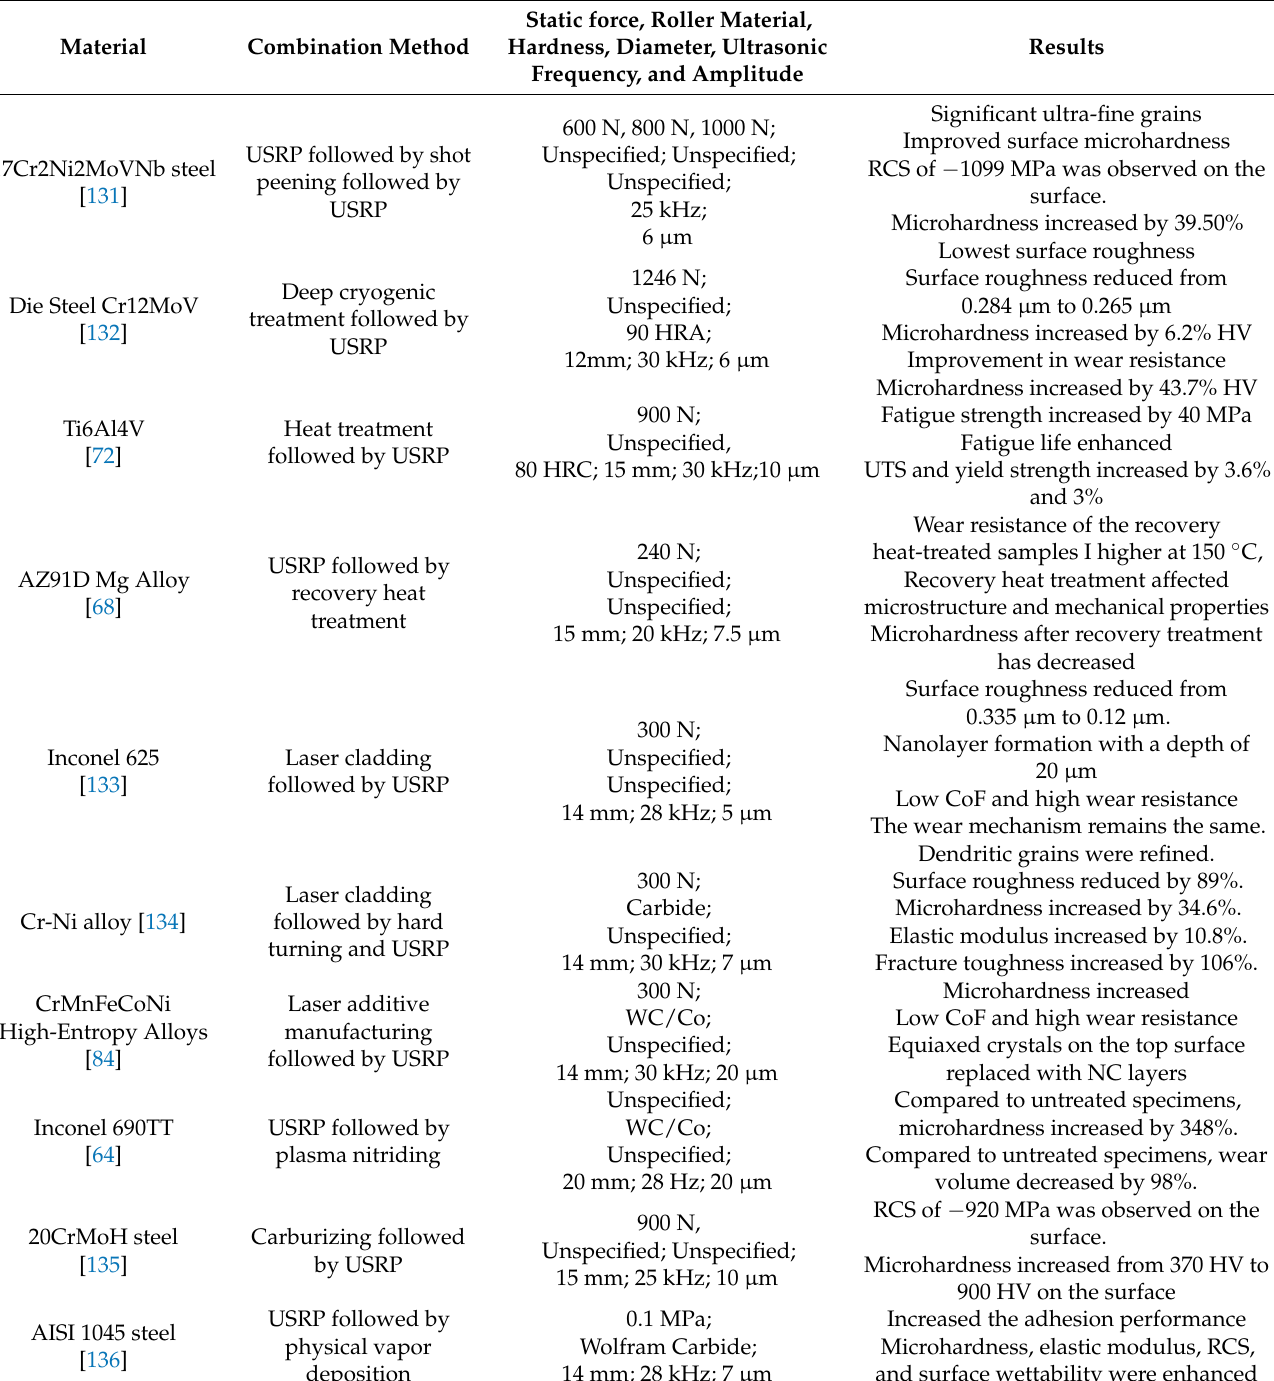
Table 3. Combination methods with